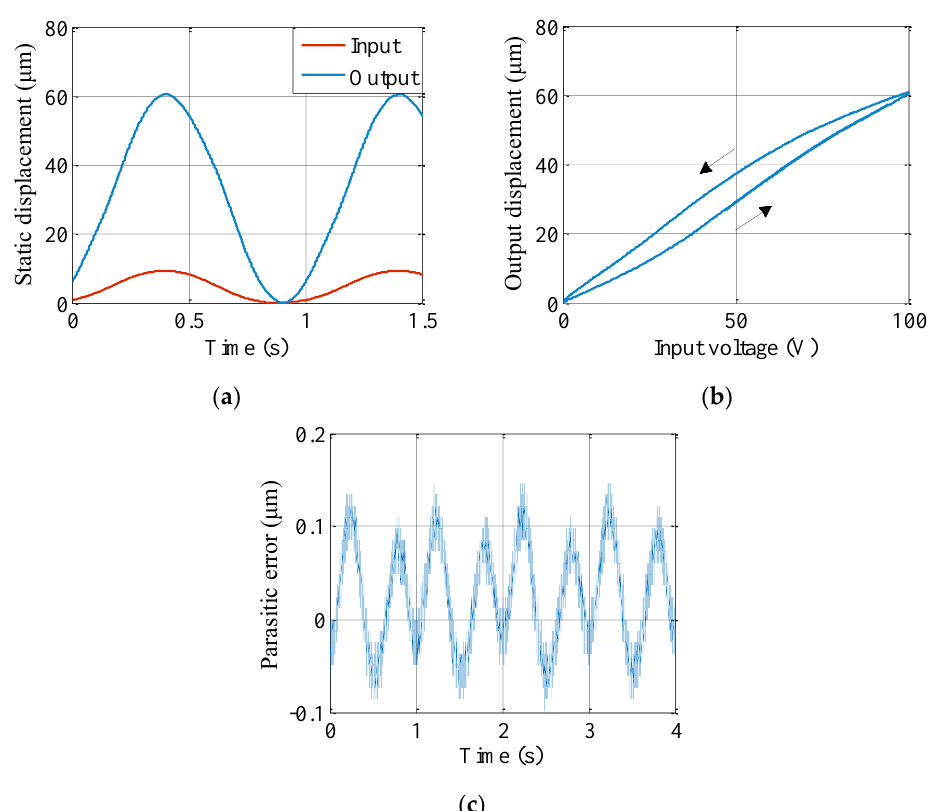
Figure 14. Experimental results of the static input and output displacements of the presented displacement amplification mechanism. ( a ) Input and output displacements. ( b ) Open-loop hysteresis characteristic. ( c ) Parasitic motion error of the output port in the x direction.